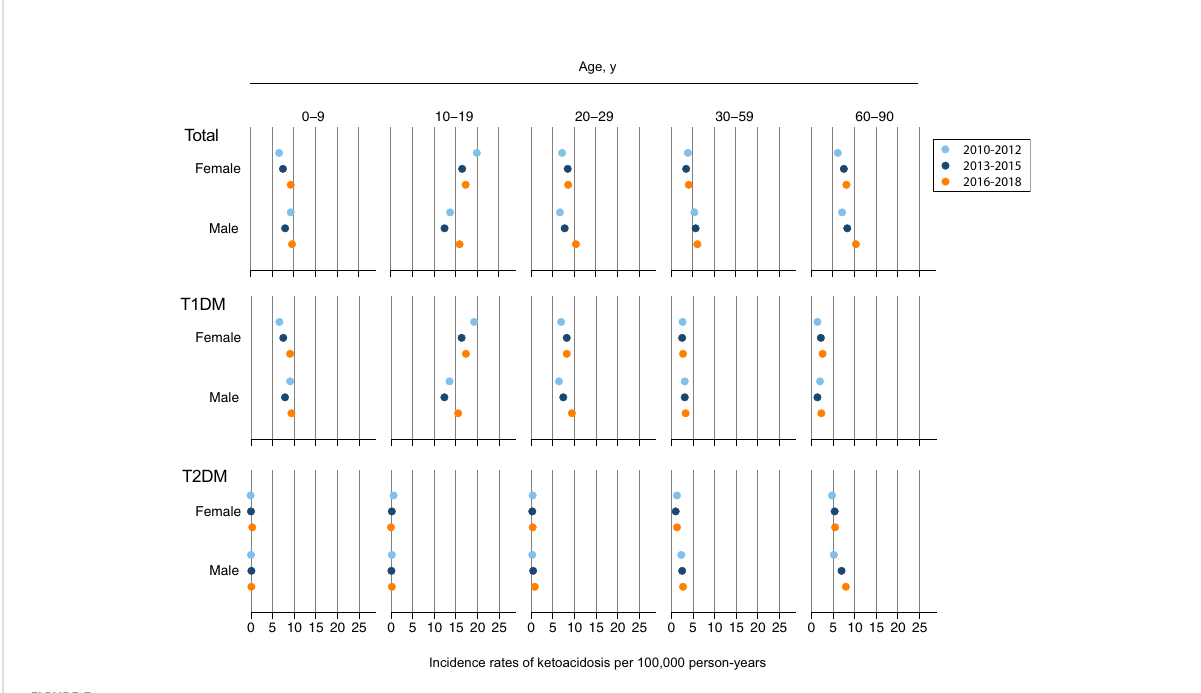
FIGURE 3 Trends of Ketoacidosis Incidence by Age, Sex, and Type of Diabetes. Shown are incidence rates per 100,000 person-years for an event of diabetic ketoacidosis for three time periods: 2010-2012 (light blue); 2013-2015 (dark blue); 2016-2018